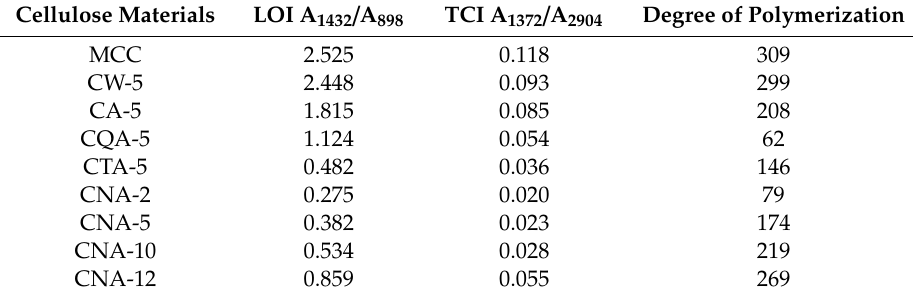
Table 3. Crystallinity index and degree of polymerization of the cellulose